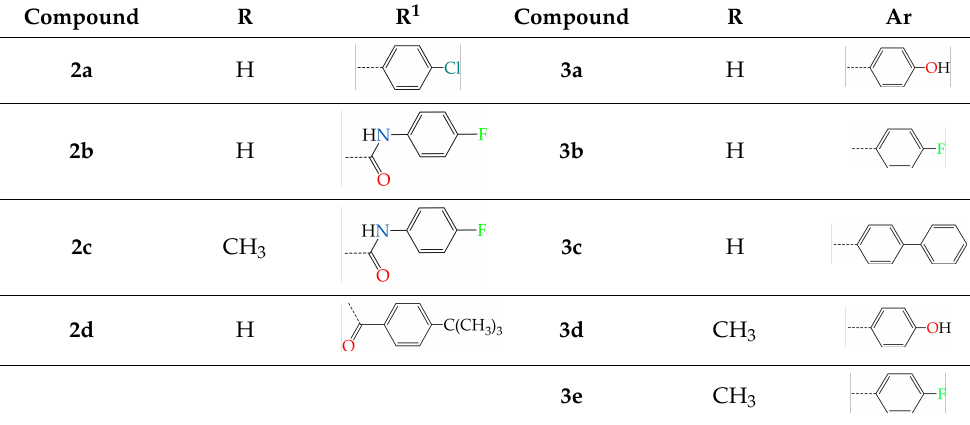
Table 2. Radicals R, R 1 of compounds 2a–d , radicals R, Ar of compounds 3a–e